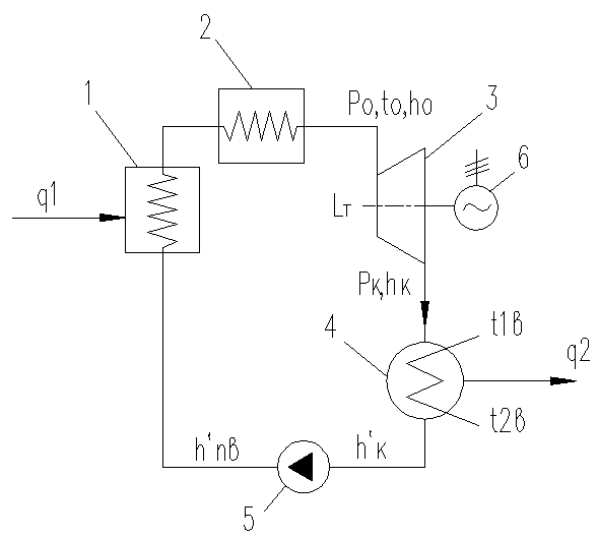
Figure 4. The simplest scheme of a steam turbine plant.